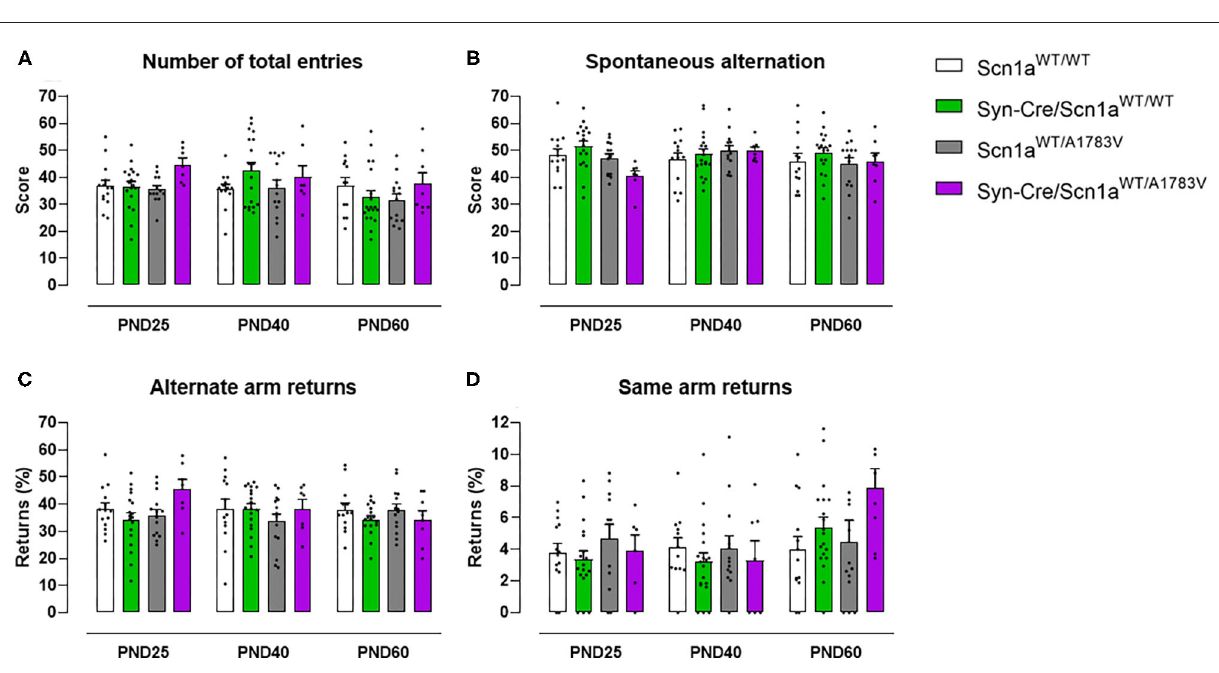
statistics for the % of same arm returns [genotype: F (3, 148)